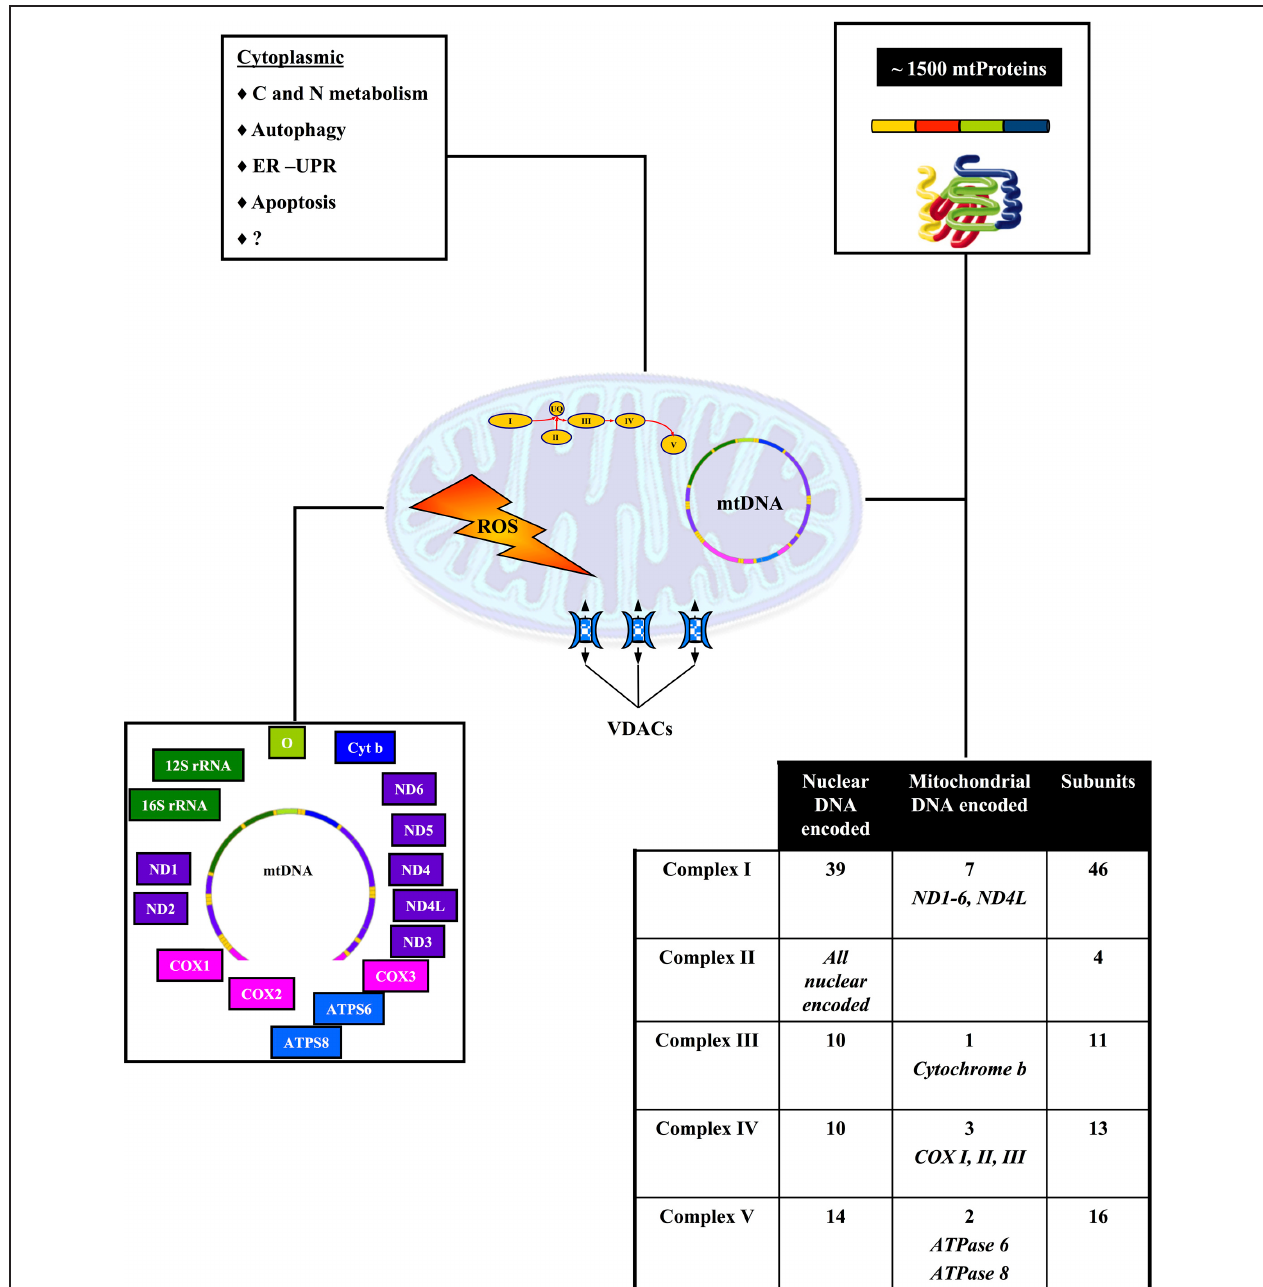
FIGURE 2 | Biogenesis of mitochondria results from the interaction of two genomes. The chart outlines the role of the nuclear and mitochondrial genomes in mitochondrial biogenesis and function. See text for further details.